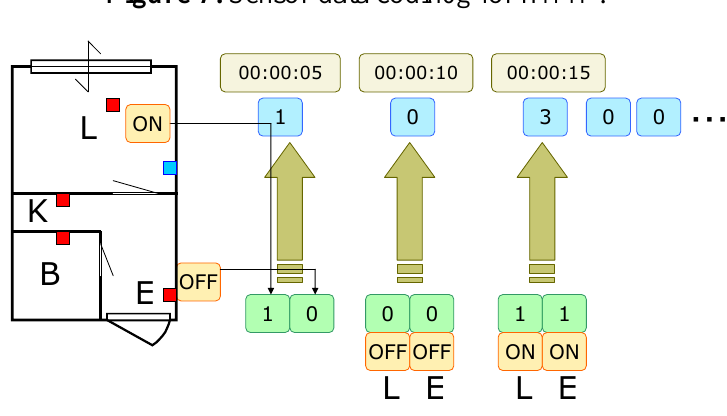
Figure 7. Sensor data codin0g for